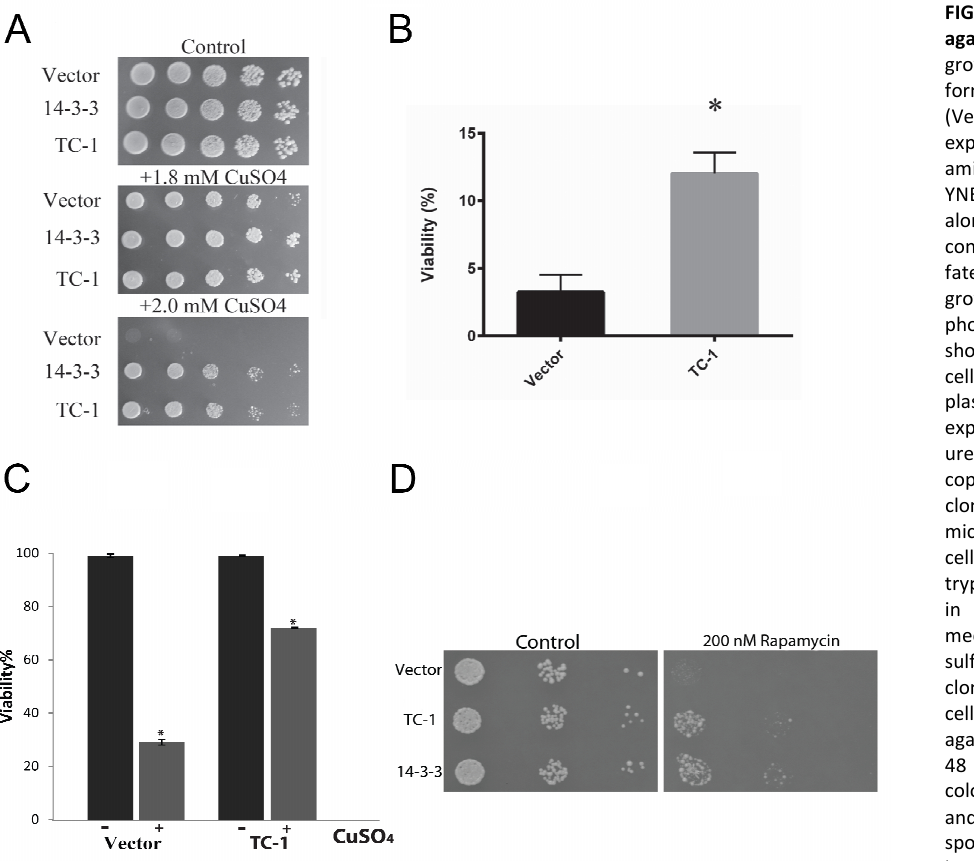
2: TC-1 protects against copper. The growth of yeast cells